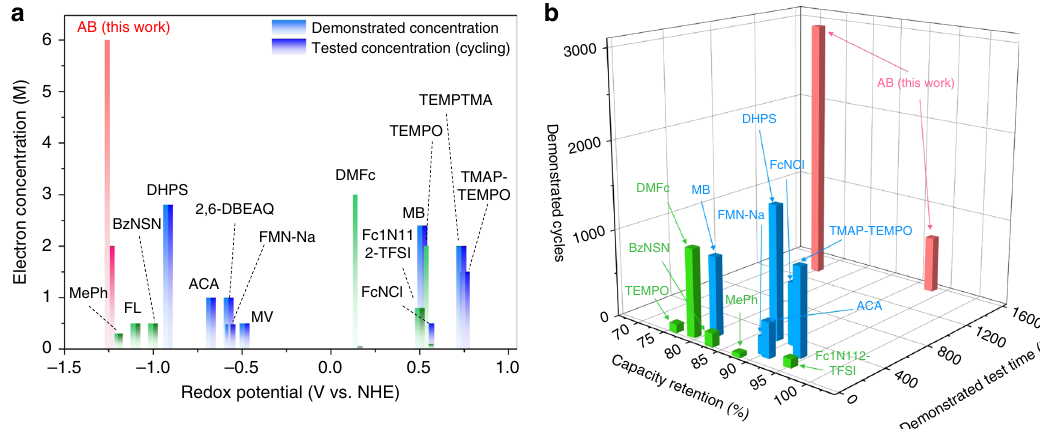
Fig. 5 Performance comparison. a Comparison of equivalent electron concentration demonstrated in electrochemical tests for AB (red) and various organic molecules in aqueous (blue) or nonaqueous (green) RFBs. b Comparison of demonstrated cycles and corresponding test time and capacity retention of AB (red) and various organic molecules in aqueous (blue) or nonaqueous (green) RFBs. DHPS (7,8-dihydroxyphenazine-2-sulfonic acid), 2,6- DBEAQ (4,4 ′ -((9,10-anthraquinone-2,6-diyl)dioxy)dibutyrate), ACA (alloxazine 7/8-carboxylic acid), FMN-Na ( fl avin mononucleotide), MV (methyl viologen), FcNCl ((ferrocenylmethyl)trimethylammonium chloride), MB (methylene blue), TEMPTMA (N,N,N-2,2,6,6-heptamethylpiperidinyl oxy-4- ammonium chloride), TMAP-TEMPO (4-[3-(trimethylammonio)propoxy]-2,2,6,6-tetramethylpiperidine − 1-oxyl chloride), MePh (N-methylphthalimide), FL (9- fl uorenone), BzNSN (2,1,3-benzothiadiazole), DMFc (1,1-dimethylferrocene), TEMPO (2,2,6,6-tetra-methylpiperidine-1-oxyl),